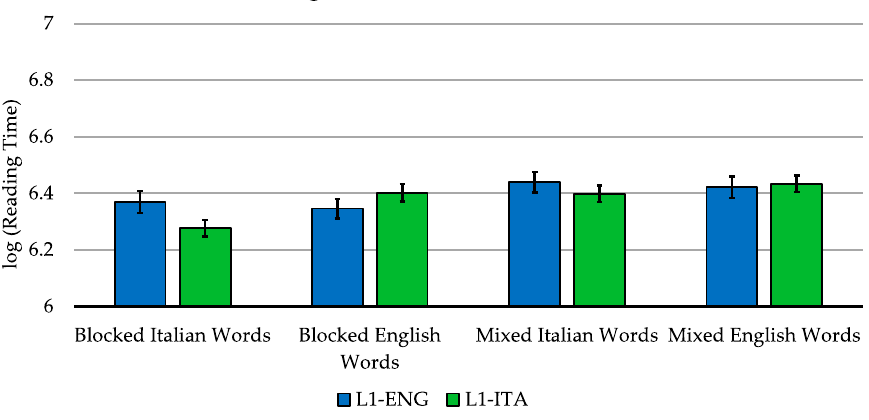
Figure 3. Reading in blocked and mixed trials: mean log-transformed voice onset times for block and mixed trials in the two languages for L1-Italian and L1-English bilinguals. Error bars indicate the standard error of the mean. The reading times refer to accurate trials.